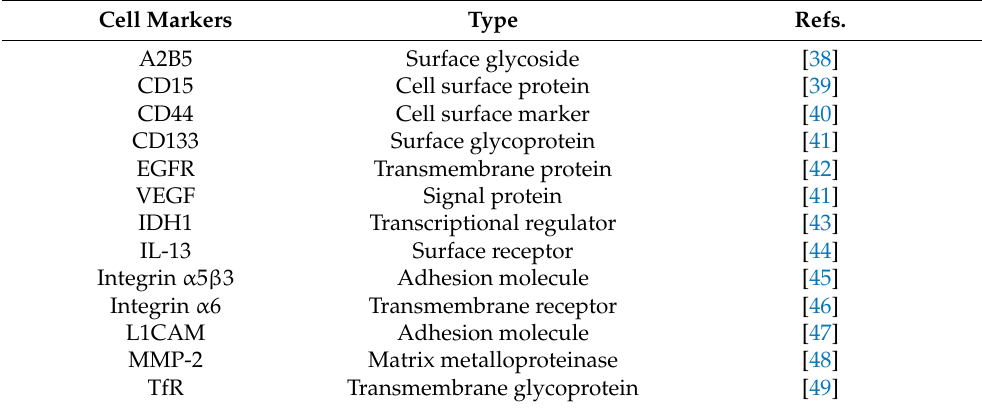
Figure 4. ( A ) Active targeting drug delivery in tumor tissue and ( B ) schematic representation of the receptor-mediated endocytosis process: ( a ) NP modified with ligand; ( b ) NP recognition and binding to the cell membrane receptor; ( c ) NP entrapped in the endosome; ( d ) endosomal escape; and ( e ) drug release into the cell cytoplasm. Table 1. Cellular markers used in GBM